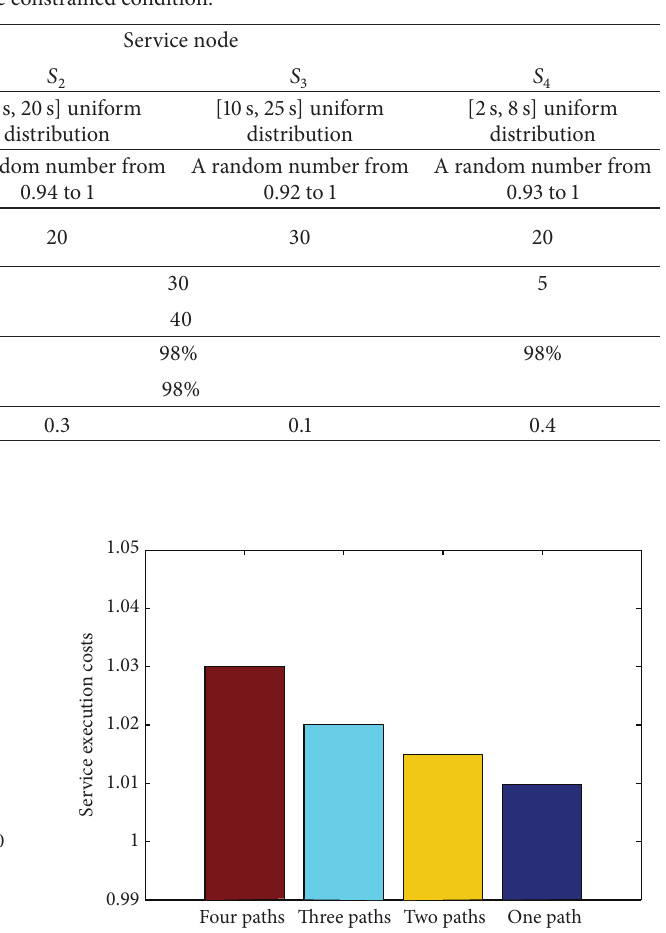
Table 1: Service constrained condition.